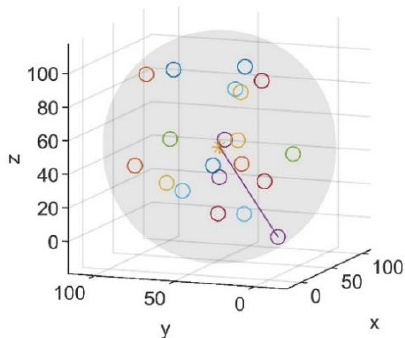
Figure 2. Schematic diagram of the outer boundary of the cluster.